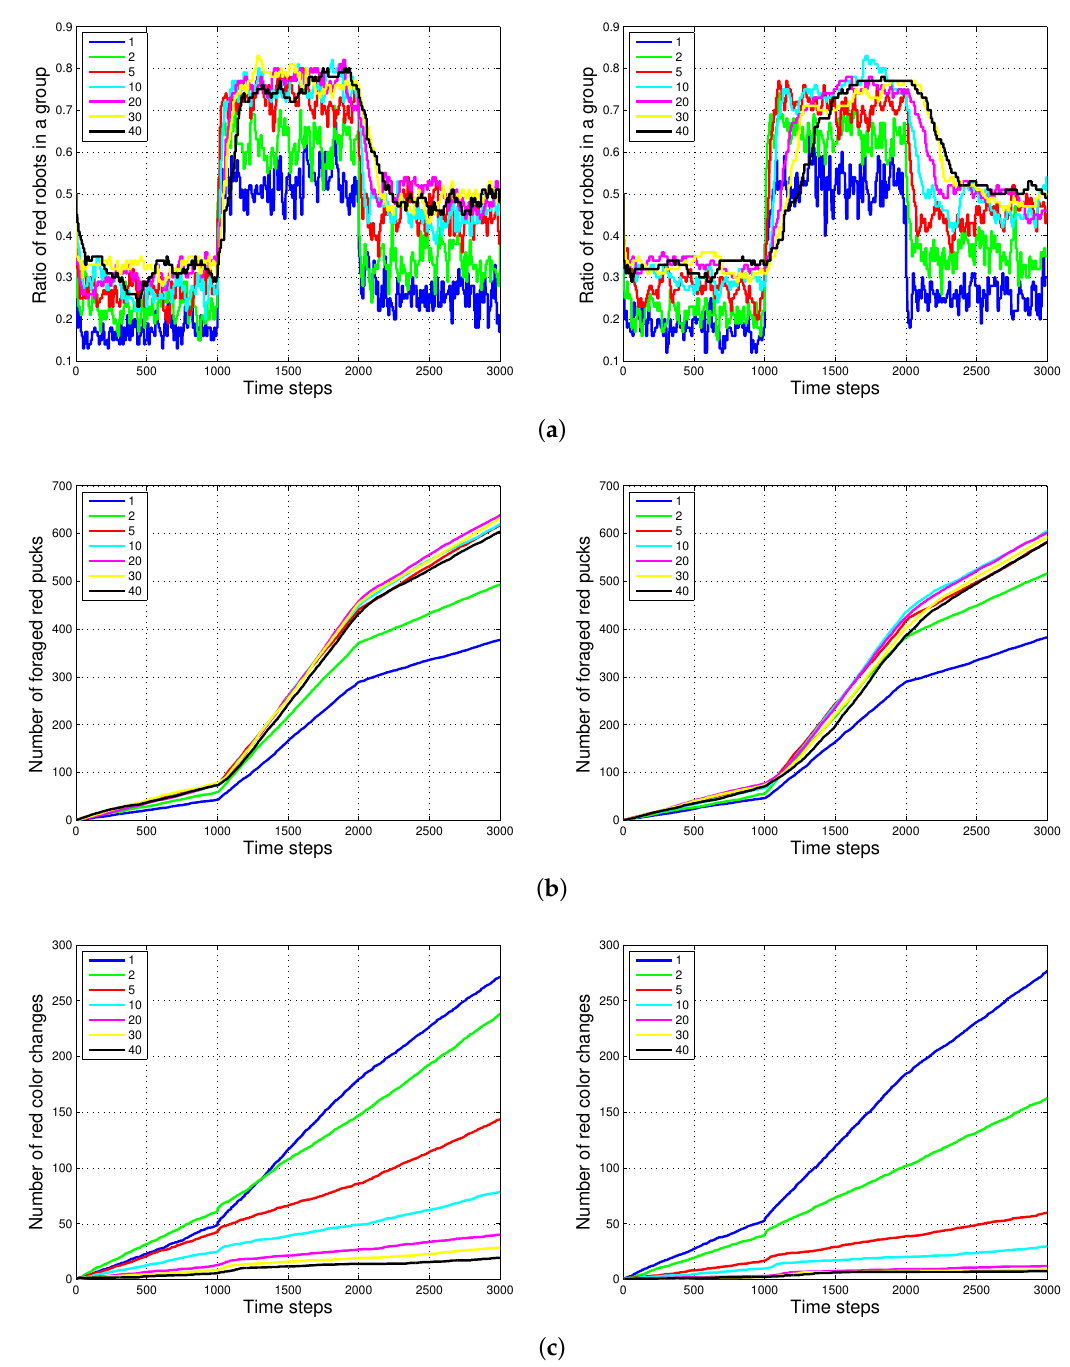
Figure 8. Performance of the History1 and History2 methods with various lengths of the puck history. The various colors indicate varying sizes of the puck history from L = 1 to L = 40. ( a ) Ratio of red robots in a group in History 1 (left) and History 2 (right); ( b ) number of foraged red pucks in History 1 (left) and History 2 (right); ( c ) number of task changes for red pucks in History 1 (left) and History 2